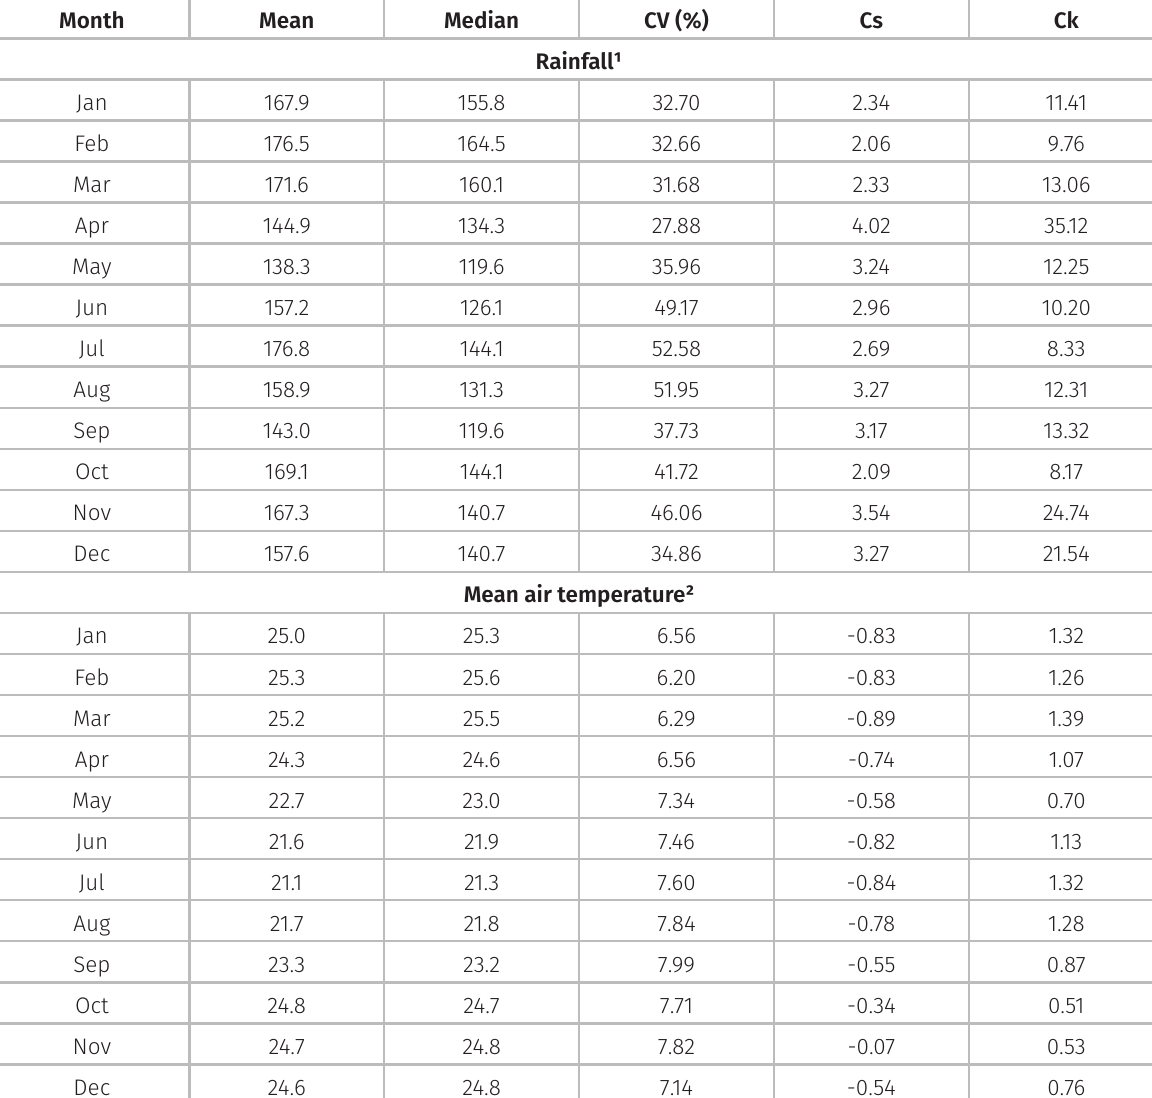
Table I. Monthly descriptive statistics of rainfall and mean air temperature in the state of